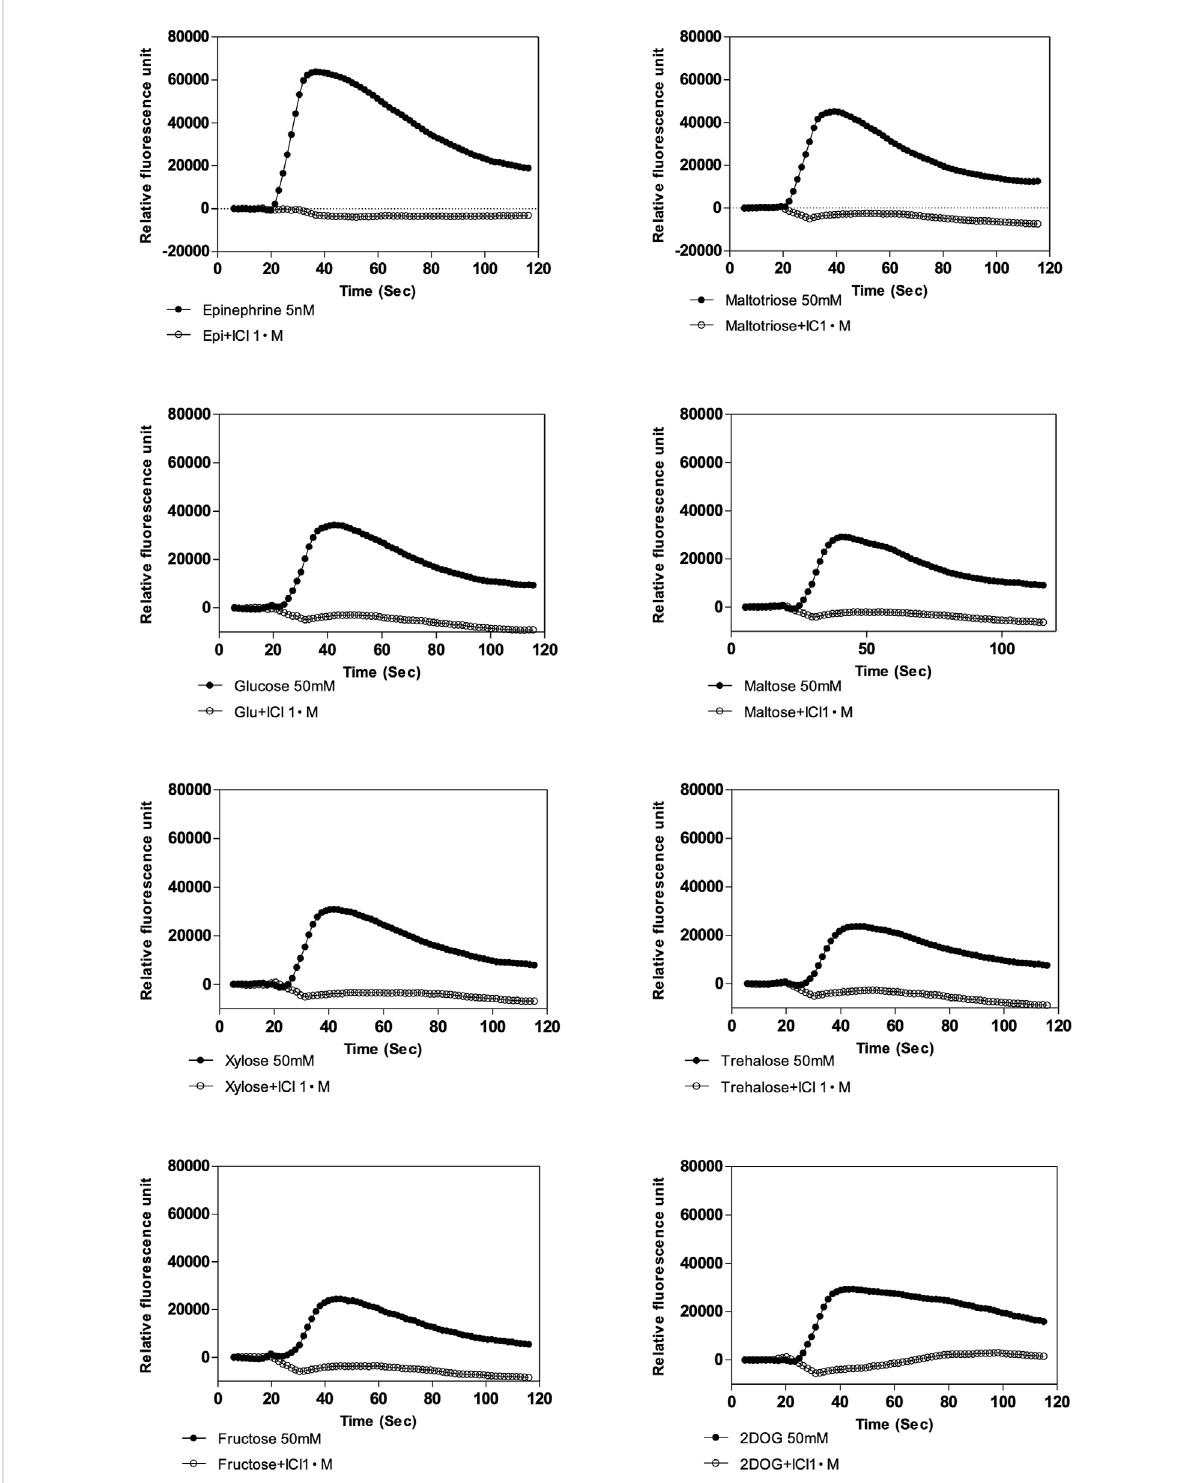
FIGURE 4 Effect of β 2 -speci fi c antagonist, ICI 118,551 on calcium response elicited by epinephrine (5 nM) and various sugars (50 mM) in Flp-In-293 cells stably transfected with ADRB2 and GNA15. One µM ICI 118,551 inhibits epinephrine- and sugar-elicited β 2 -AR -mediated calcium responses. X -axis shows time in s, and y -axis displays fl uorescence intensity (arbitrary units). Representative results are shown from at least three repetitions.